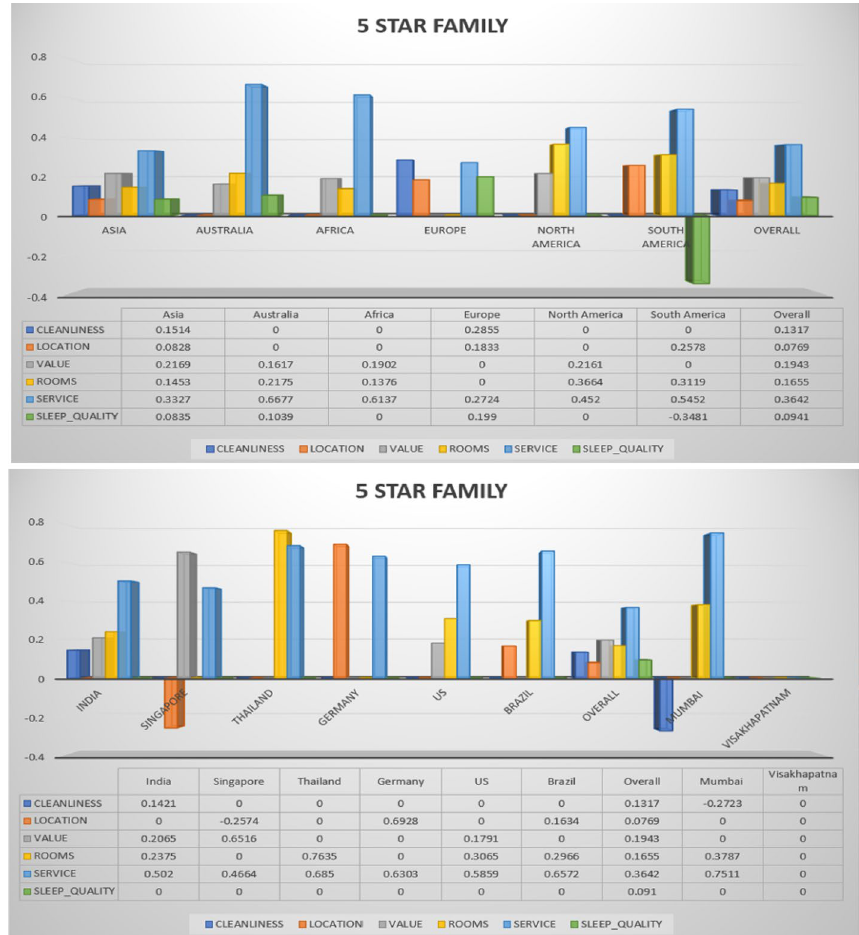
Fig. 5 Hotel class: 5 star, Trip Type: Travelled with family (continent, country and